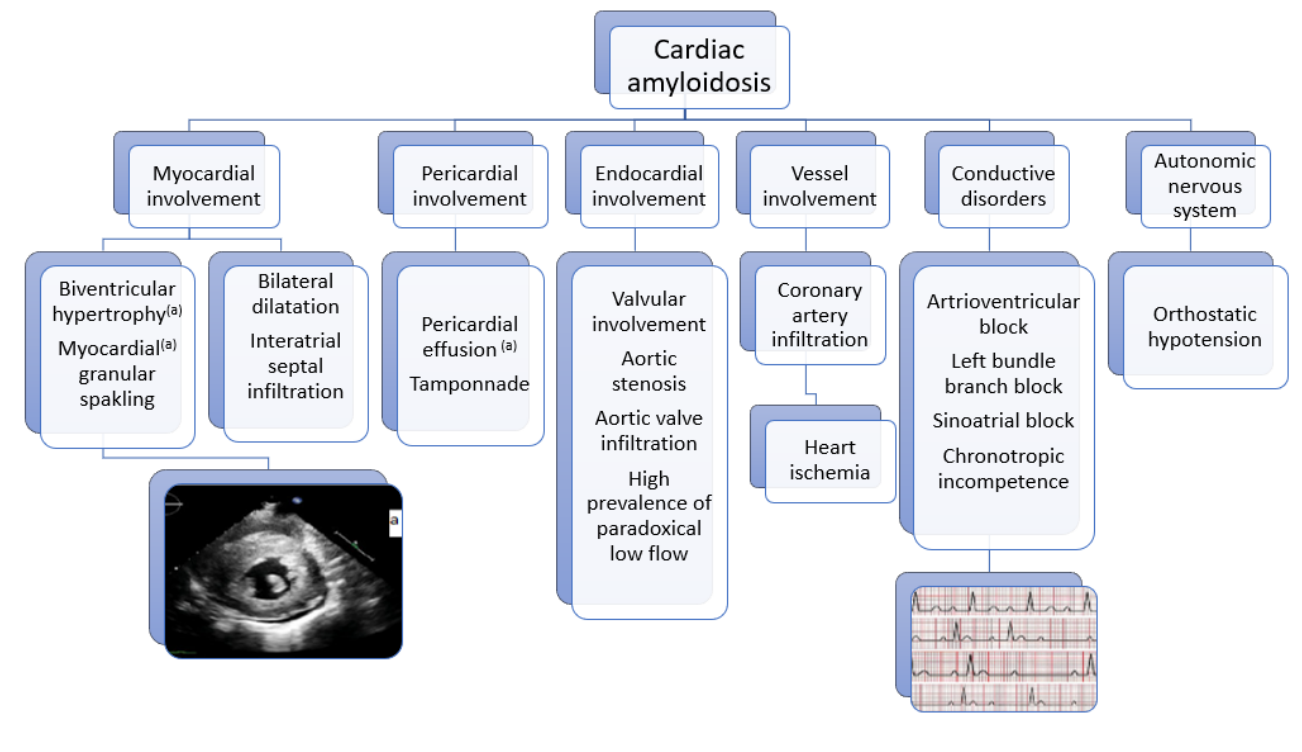
Figure 1. Clinical picture of CA.